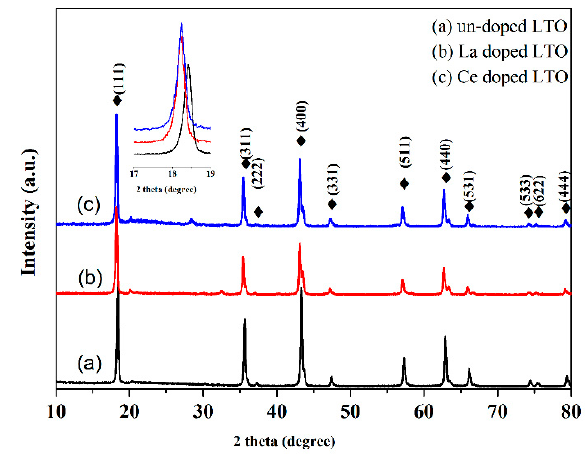
Figure 1. X-ray diffraction (XRD) patterns of pure Li 4 Ti 5 O 12 (LTO), undoped LTO ( a ), La-doped LTO ( b ) and Ce-doped LTO ( c ).